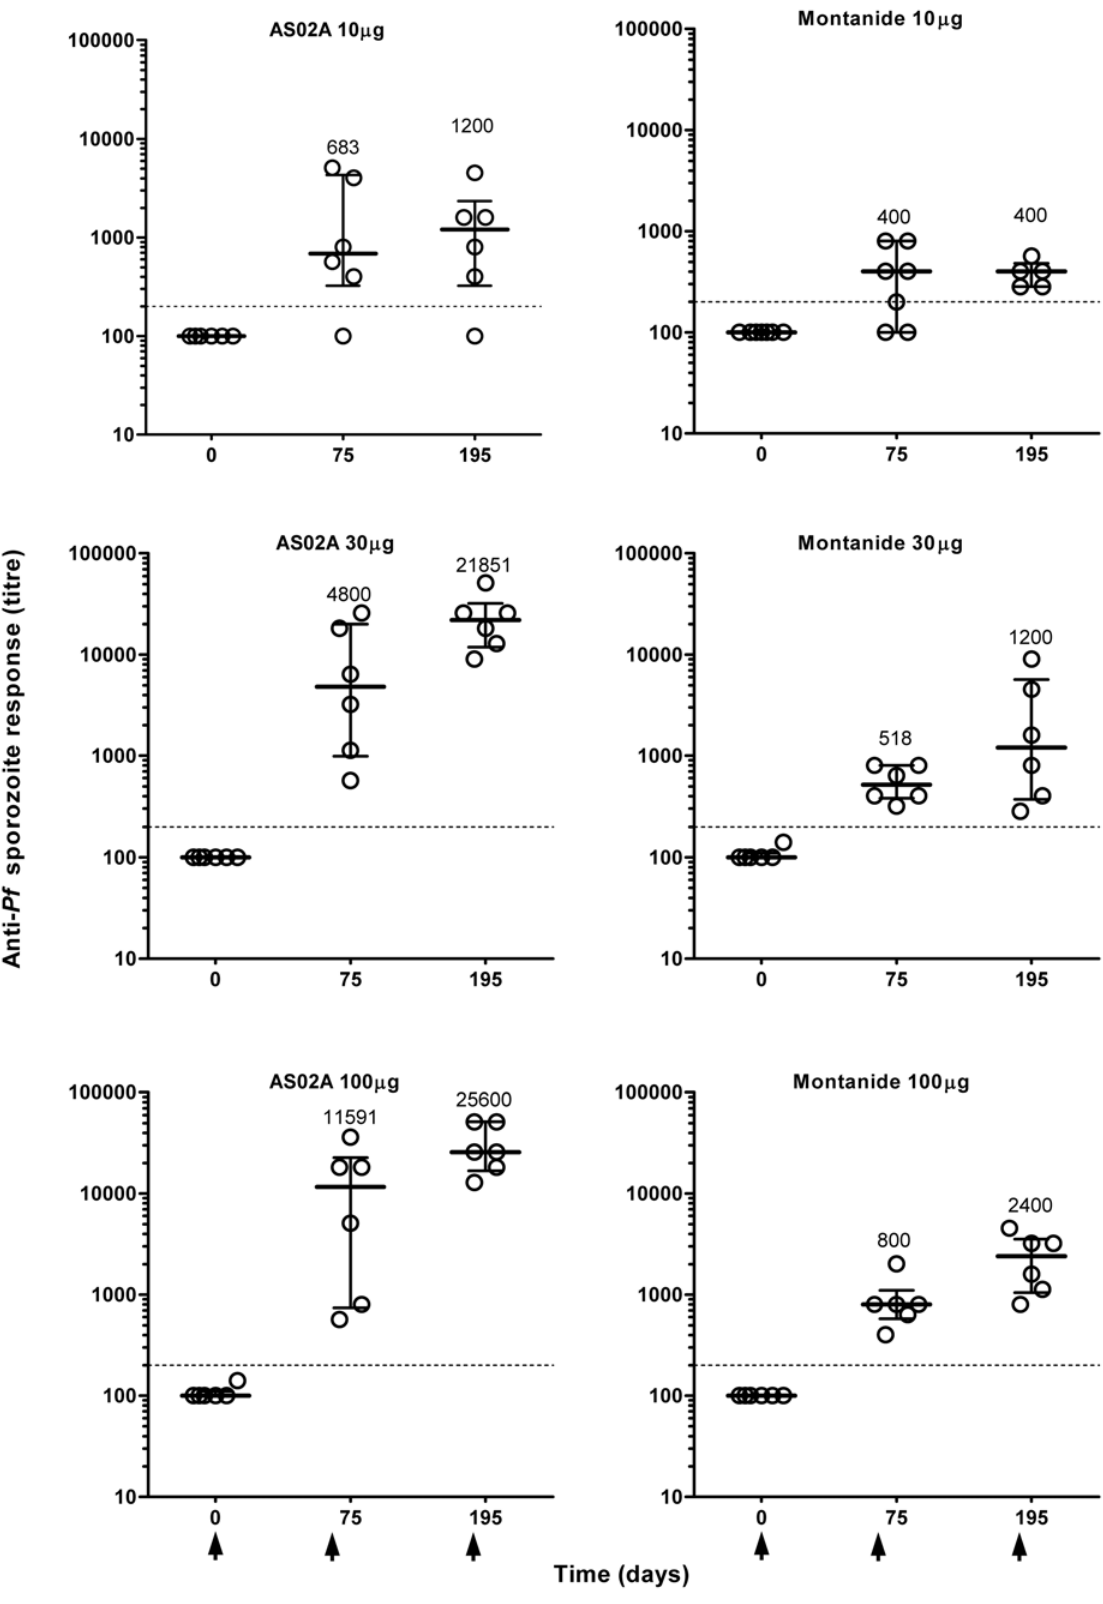
Figure 3. Time-course of anti- Plasmodiumfalciparum antibody response upon PfCS102 immunization. Anti-parasite antibodies were measured in plasma samples by immunofluorescence. Results are expressed as individual titers for each immunization group, with quartiles. Arrows indicate the times of vaccination.